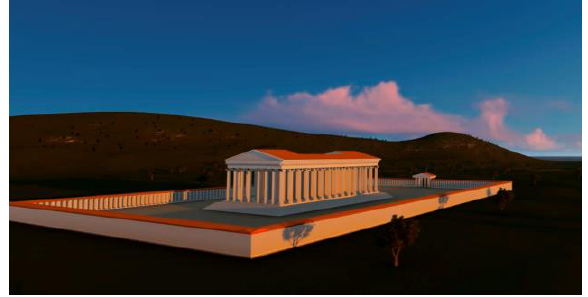
Figure 12. Reconstruction of the Temple of Apollo Smintheion at Troas